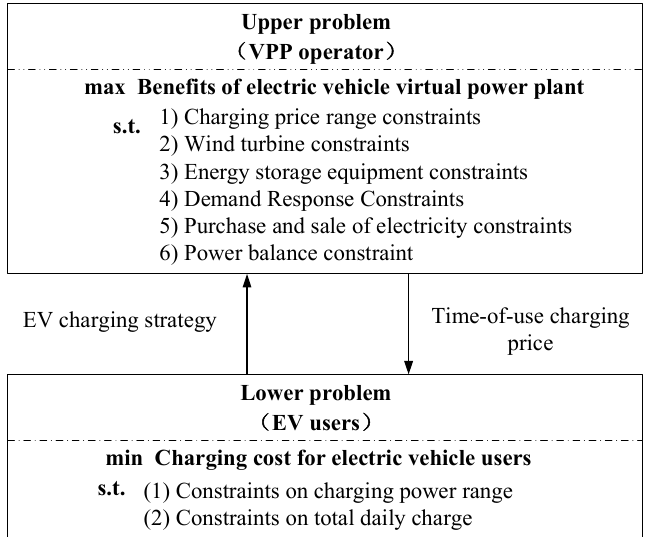
Figure 2. The Stackelberg game structure of the VPP and EVs .